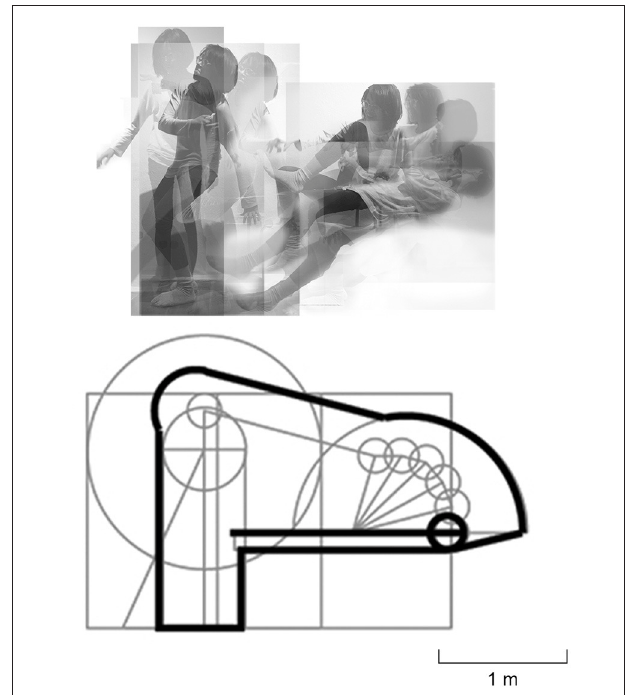
FIGURE 1 | The mapping of user movements in space used to design the student-housing